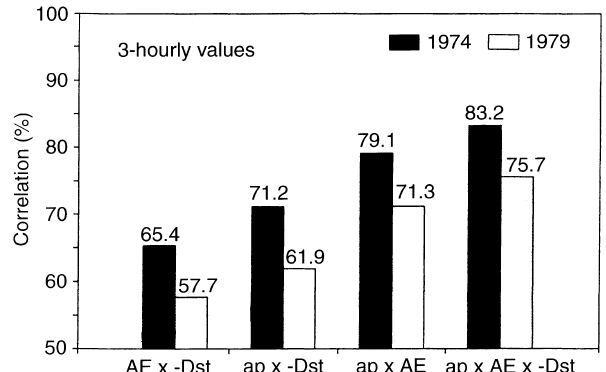
Fig. 7. Annual correlations and multiple correlation for 1974